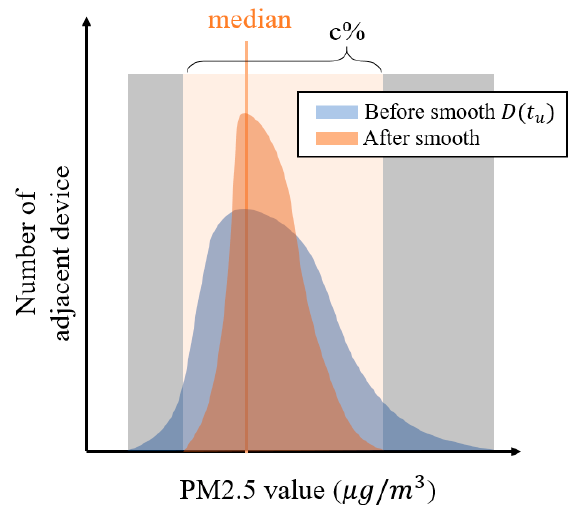
Figure 6. Schematic diagram of the smooth approach.